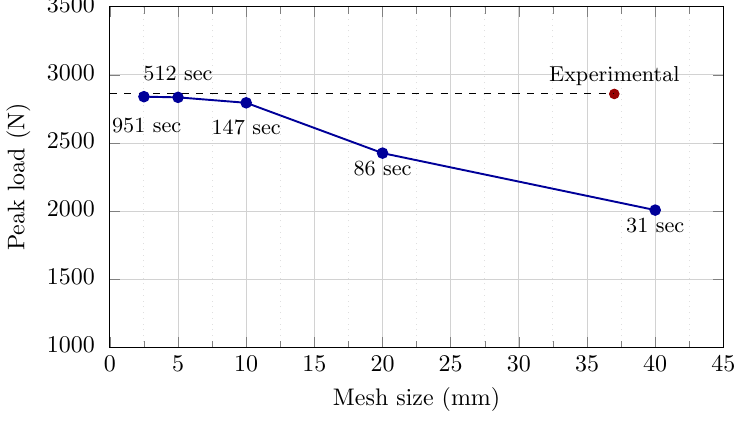
Figure 11. Peak load and run time comparison between the FEA results derived by increasing the mesh size and the peak load acquired from experimental